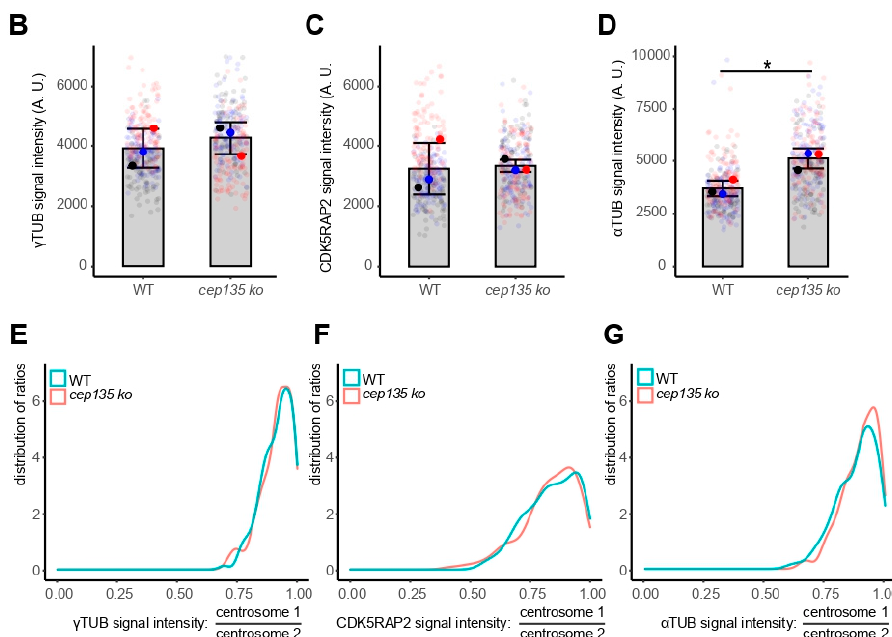
Figure 8. The two poles of metaphase spindles are balanced in cep135 KO cells. ( A ) Representative images showing balanced spindle poles in metaphase. Scale bar: 10 µ m. ( B – D ) Signal intensity of metaphase γ -tubulin ( B ), CDK5RAP2 ( C ), and α -tubulin ( D ) signals. A total of 150 cells were measured in total for each cell line. The graph shows mean values ± SD from three independent experiments. The p -value was calculated with a two-tailed Student’s t -test. * indicates p < 0.05. ( E – G ) The distinct γ -tubulin, CDK5RAP2, and α -tubulin signals of mitotic centrosomes/spindle poles were quantified, and their ratios (higher/lower value) were determined. The plot shows the distribution of ratios ranging from 1 (equal signals) to 0 (extreme asymmetry between the two signals). A total of 150 cells were measured in total for each experimental